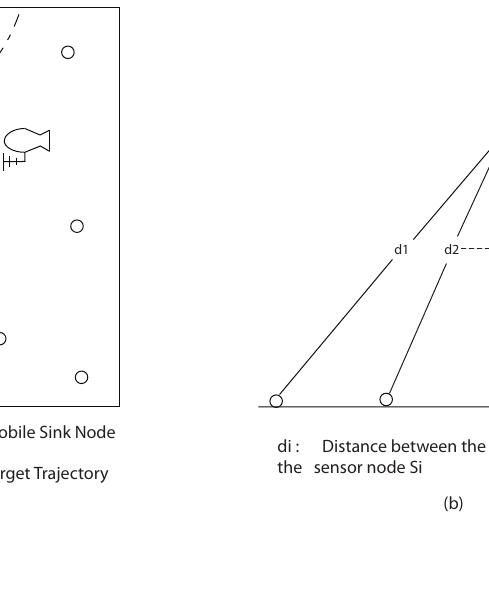
Figure 1. (a) Tracking a single target using multiple sensor nodes and a mobile sink node in the sensor network. (b) The Euclidean distances between the sensor nodes and the mobile sink